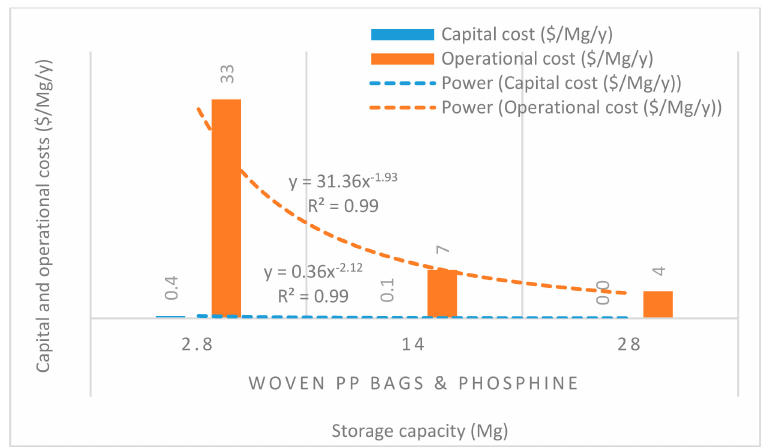
Figure 11. Economies of scale of capital and operational costs ($ / Mg / y) of using woven polypropylene bags and phosphine tablets.